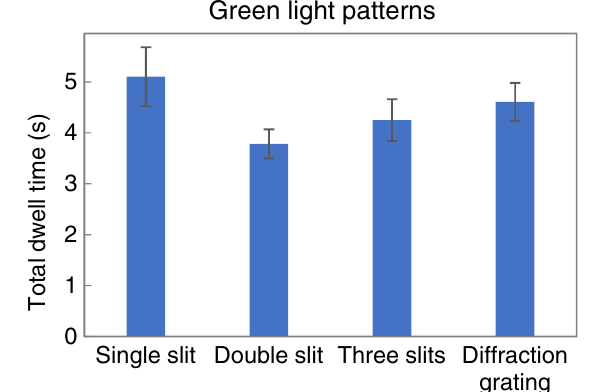
FIG. 9. Total dwell times for multiple-choice patterns (single slit, double slit, three slits, and diffraction grating) produced by the green light. Total dwell time is evaluated as the sum of dwell times obtained in questions Q5, Q6, and